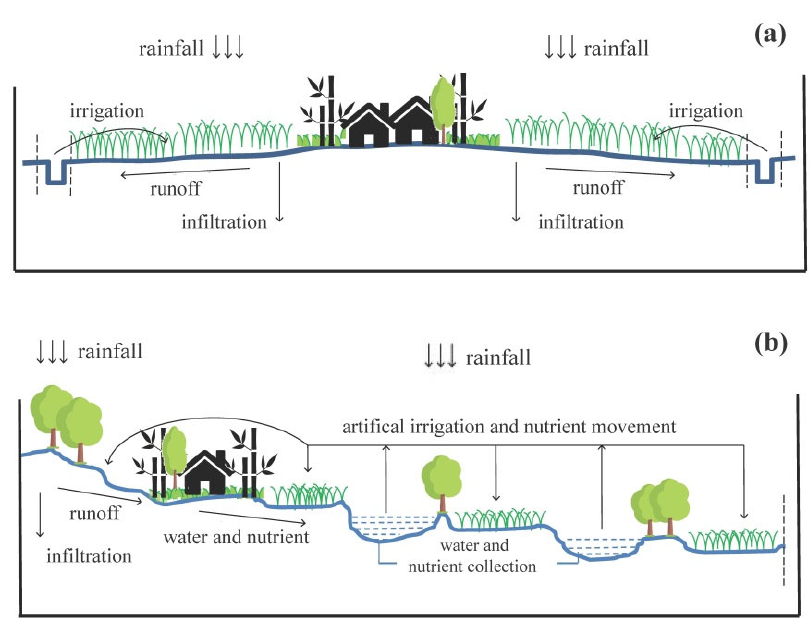
Figure 9. Conceptual modes of agricultural landscape of Paotong ( a ) and Dantu ( b ) villages.